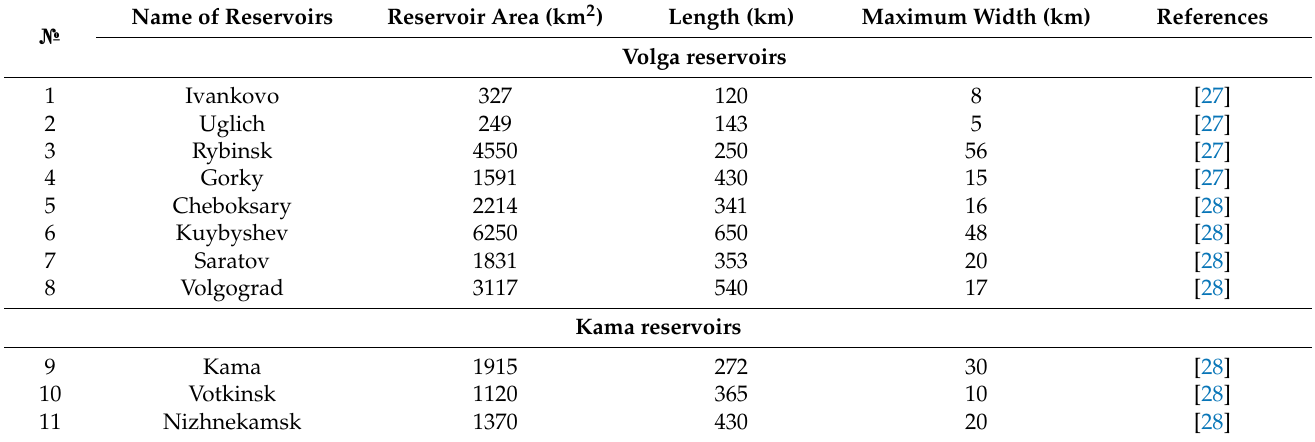
Table 1. The main morphometric characteristics of the studied reservoirs.